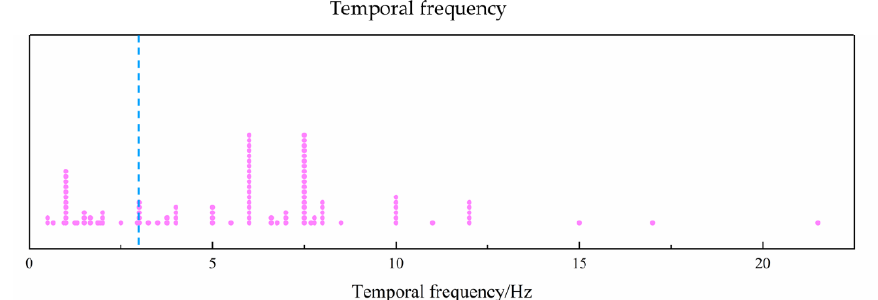
Figure 8. Temporal frequency of visual stimulus in selected studies. Dashed blue line represents critical point of 3 Hz distinguishing transient and steady-state VEP.